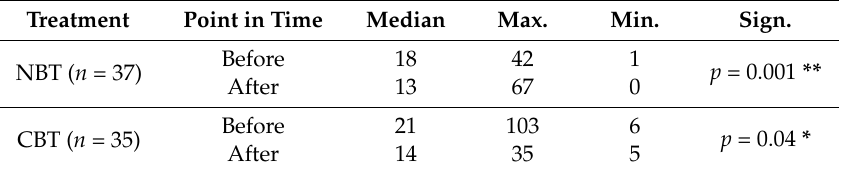
Table 3. Number of contacts with a general practitioner from twelve months before treatment to twelve months after treatment (NBT: n = 37; CBT: n = 35).